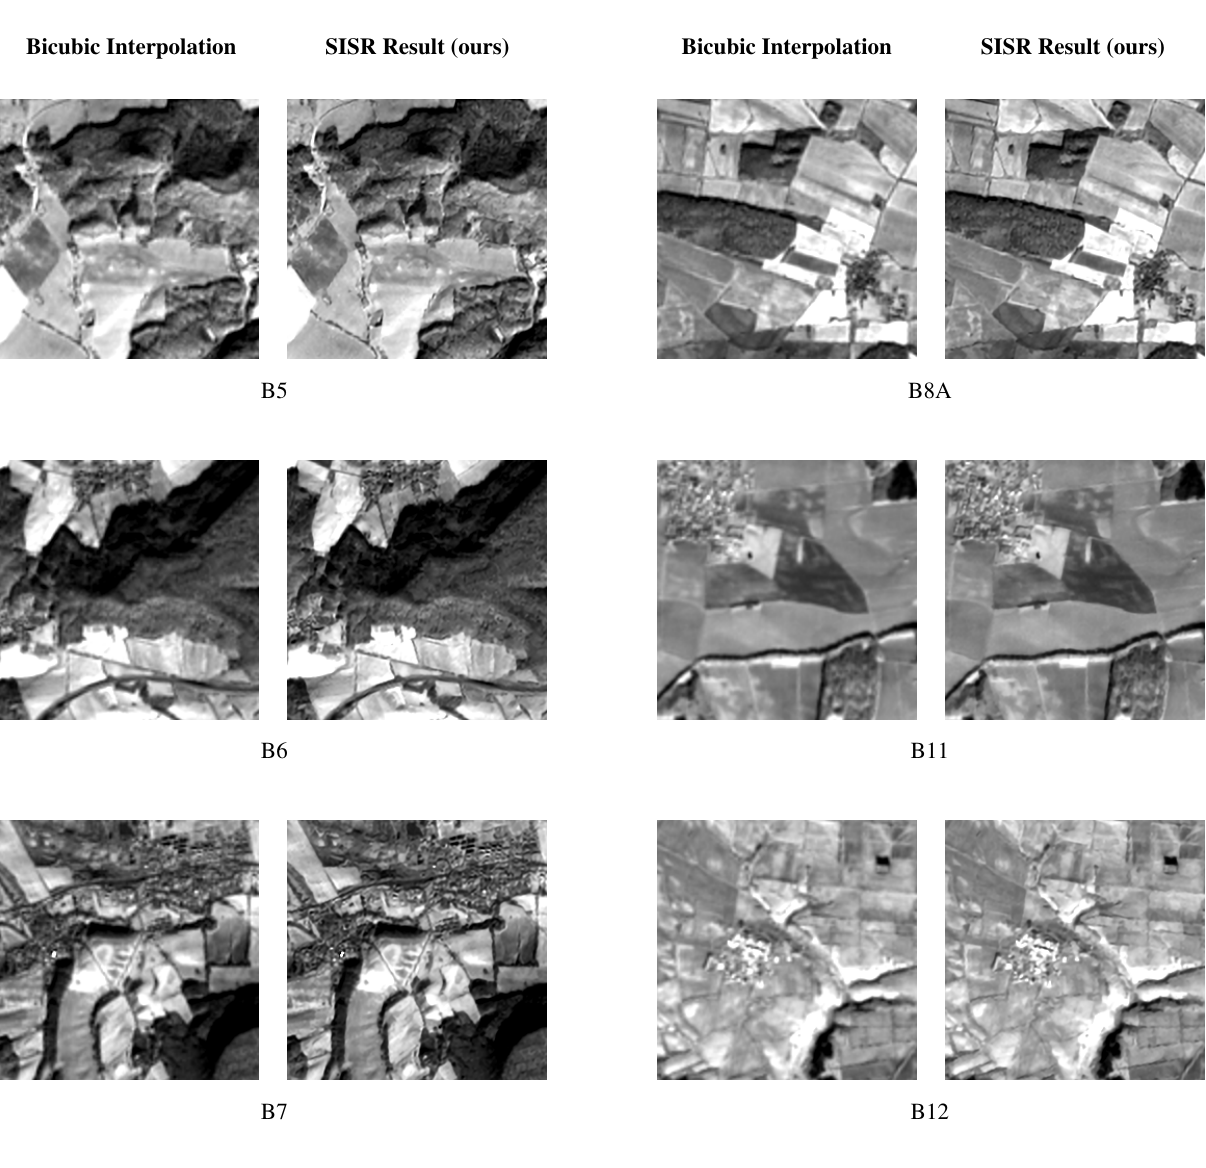
Figure 8. Super-resolution results with a GSD of 10 m for the six Sentinel-2 bands with a native GSD of 20